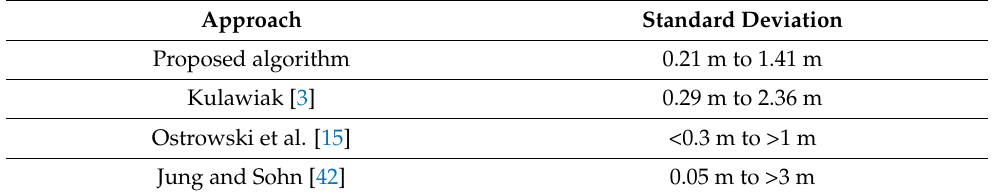
Table 2. Accuracy of the proposed approach and previous